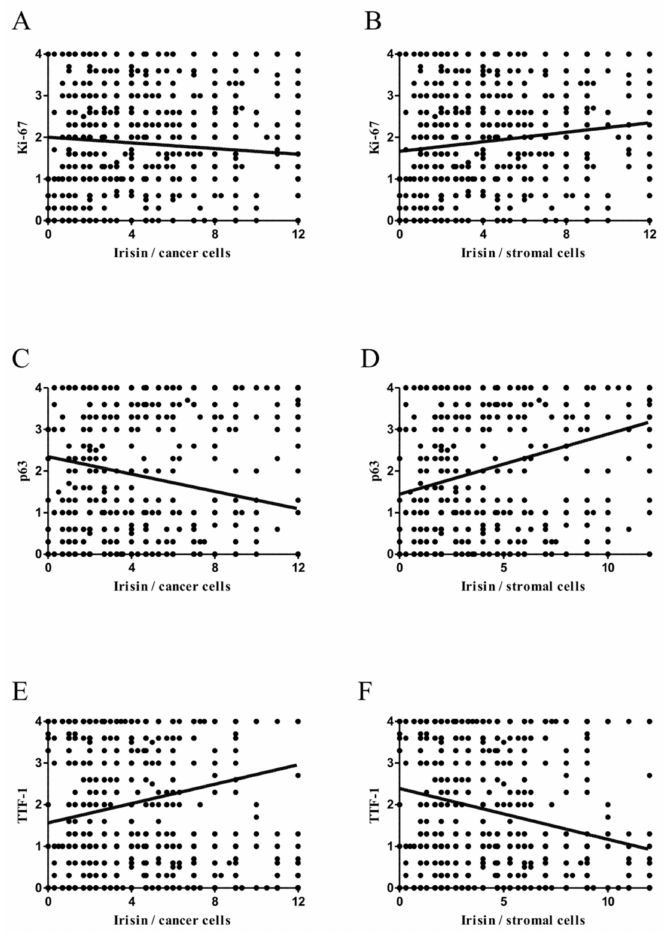
Figure 5. Correlations of irisin expression levels (cancer cells— A , C , E ; stromal cells— B , D , F ) with diagnostic markers Ki-67 ( A , B ), p63 ( C , D ) and TTF-1 ( E , F ) expression levels in NSCLC